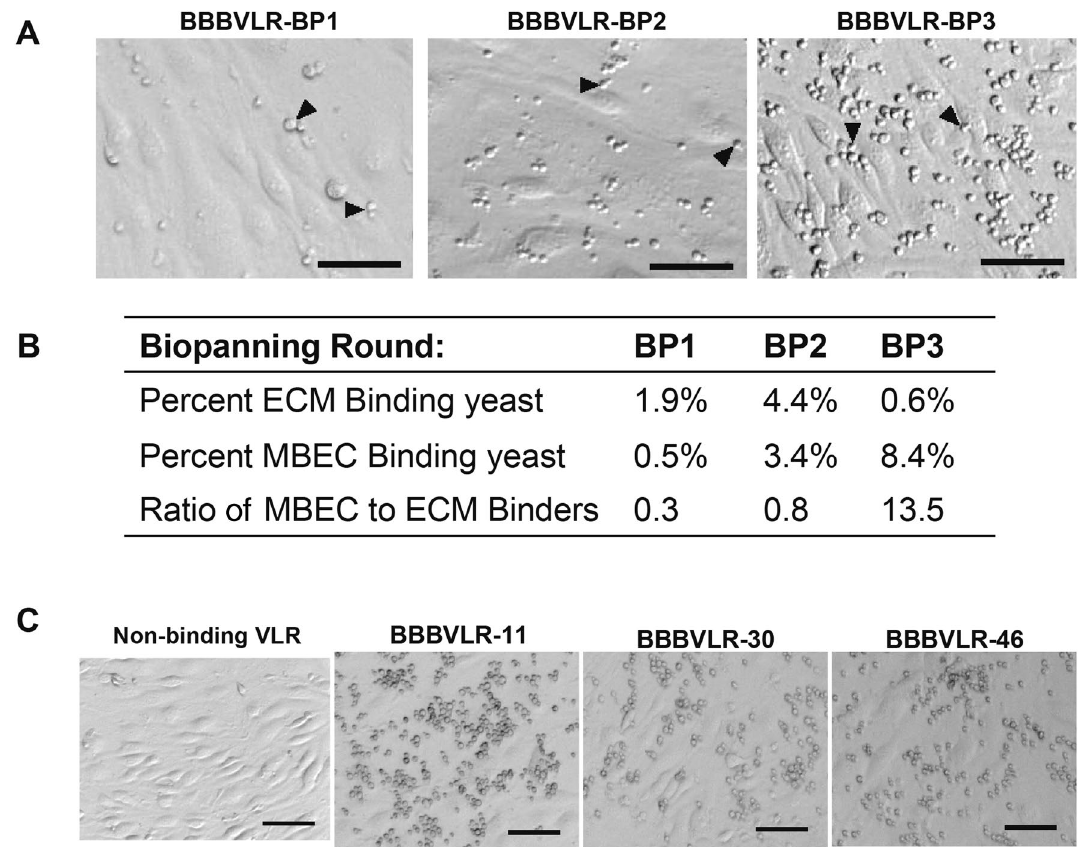
Figure 3. YSD screening of the BBBVLR library. ( A ) Representative brightfield images of yeast binding to confluent MBEC monolayers at the end of each biopanning round. Yeast are the small round cells and examples are indicated by black arrowheads. ( B ) Percentage of applied yeast that were recovered by binding to ECM and MBEC during each round of biopanning. ( C ) After the third round of biopanning, MBEC-binding VLR clones were identified via a 96-well biopanning assay using yeast displaying RBC36 VLR as a non-binding VLR control. Scale bars = 50